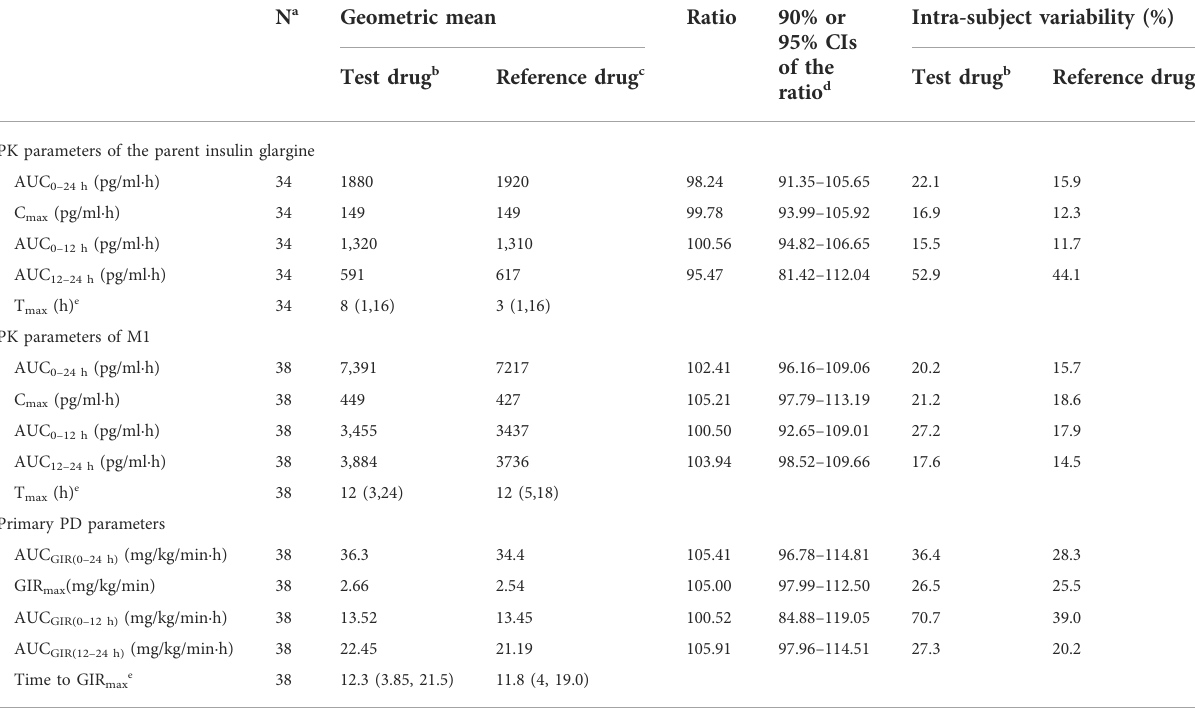
TABLE 1 Comparison of pharmacokinetic and pharmacodynamic parameters between recombinant insulin glargine developed by Wanbang and Lantus. N